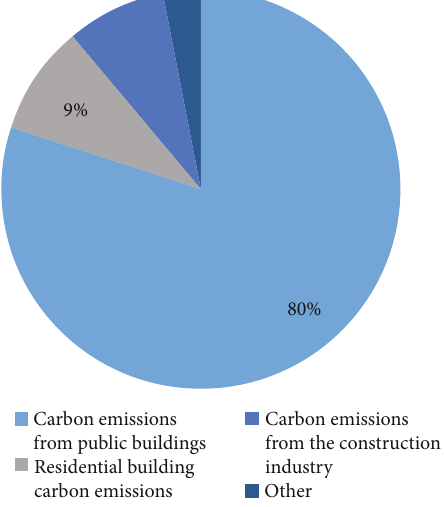
Figure 7: Relationship between carbon emission reduction and total carbon